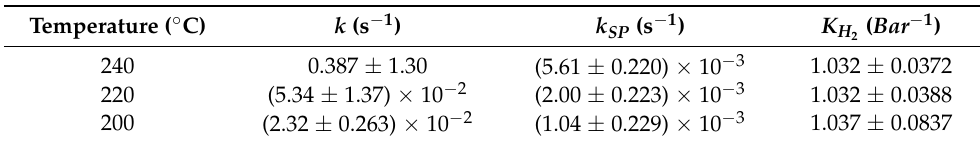
Table 9. Estimated kinetic parameters and their uncertainty for a 97.5% confidence interval for Model 4.